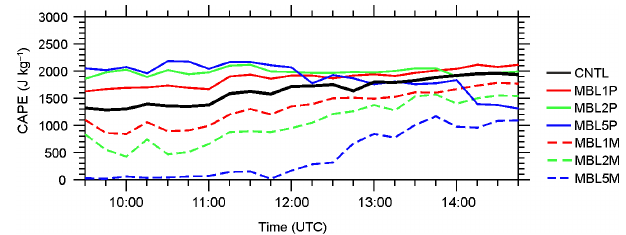
Figure 9. Temporal evolution of CAPE in the sensitivity bub- ble simulated in CNTL (black line), MBL × P (solid lines), and MBL × M (dashed line) from 09:30 to 14:45UTC on 14 Octo- ber